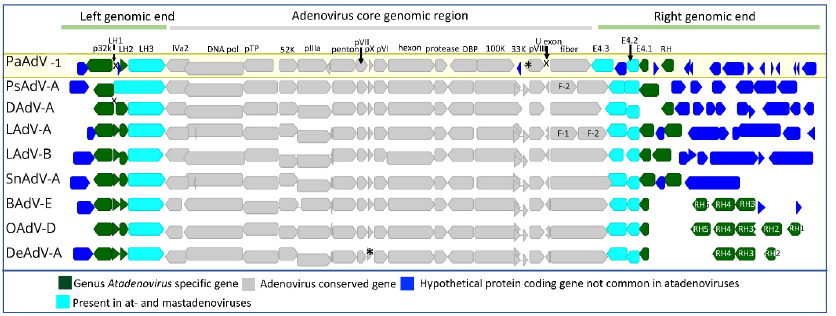
Figure 1. Schematic diagram of atadenovirus genome comparison. Complete atadenovirus genomes were extracted from the following: NCBI (passerine adenovirus 1 (PaAdV-1), GenBank Ac no. MT674683; Psittacine atadenovirus A (PsAdV-A), GenBank Ac no. KJ675568; Duck adenovirus A (DAdV-A), GenBank Ac no. KF286430; Lizard atadenovirus A (LadV-A), GenBank Ac no. KJ156523; Lizard atadenovirus B (LadV-B), GenBank Ac no. MT050041; Snake atadenovirus B (SnAdV-B), GenBank Ac no. DQ106414; Bovine atadenovirus B (BadV-B), GenBank Ac no. JQ345700; Ovine atadenovirus A (OadV-B), GenBank Ac no. NC_004037 and Deer atadenovirus B (DeAdV-B), GenBank Ac no. MK343439) and they were aligned with MAFTT (version 7.388) [21] in Geneious Prime ® (version 2022.1.1, Biomatters, New Zealand). Adenovirus conserved genes, genus-specific genes, and species- specific hypothetical open reading frames are presented in different colours. The significance of missing conserved genes in the presented genomes is marked with X, and genes present, but not an- notated are represented with a star (*). F-1 and F-2 are the abbreviations for fibre 1 and 2,